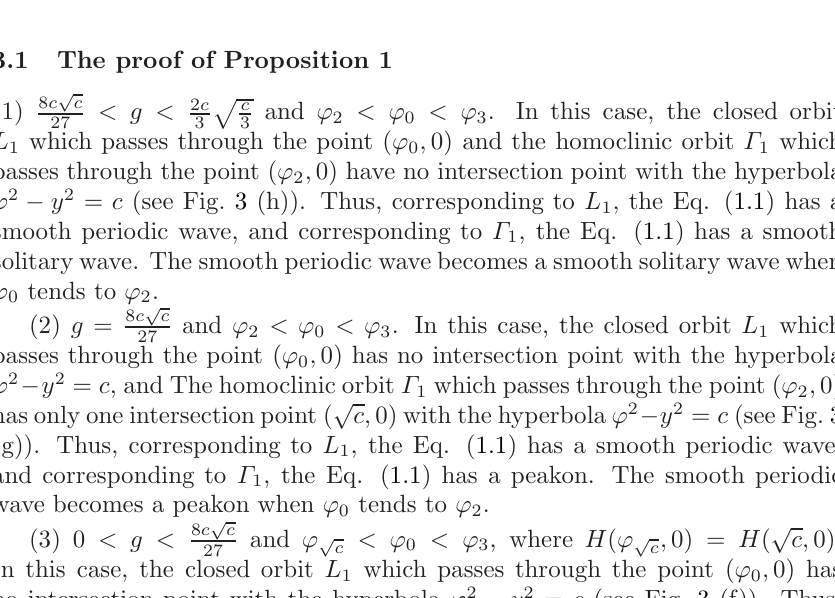
√ c 27 ; (d) g = − √ √ c c 8 c 8 c c 2 c 27 ; (h) 27 < g < 3 q 3 ; (i) g =